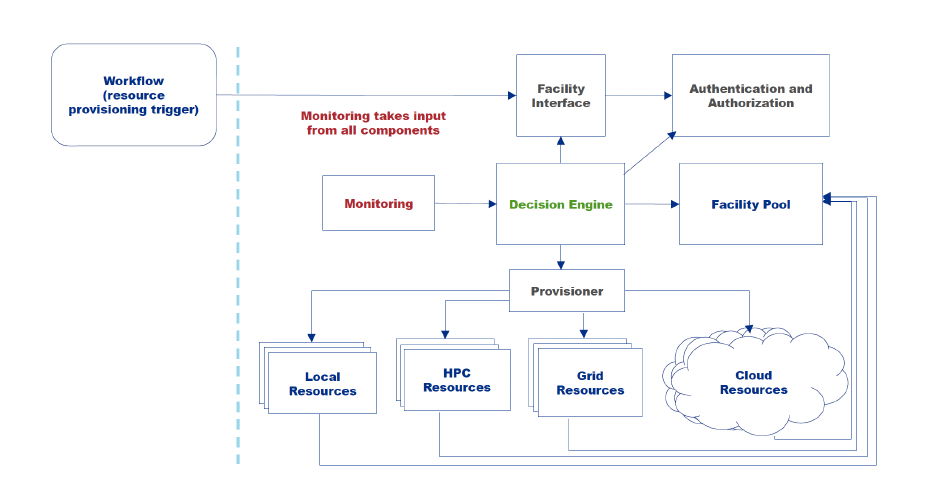
Figure 3. HEPCloud